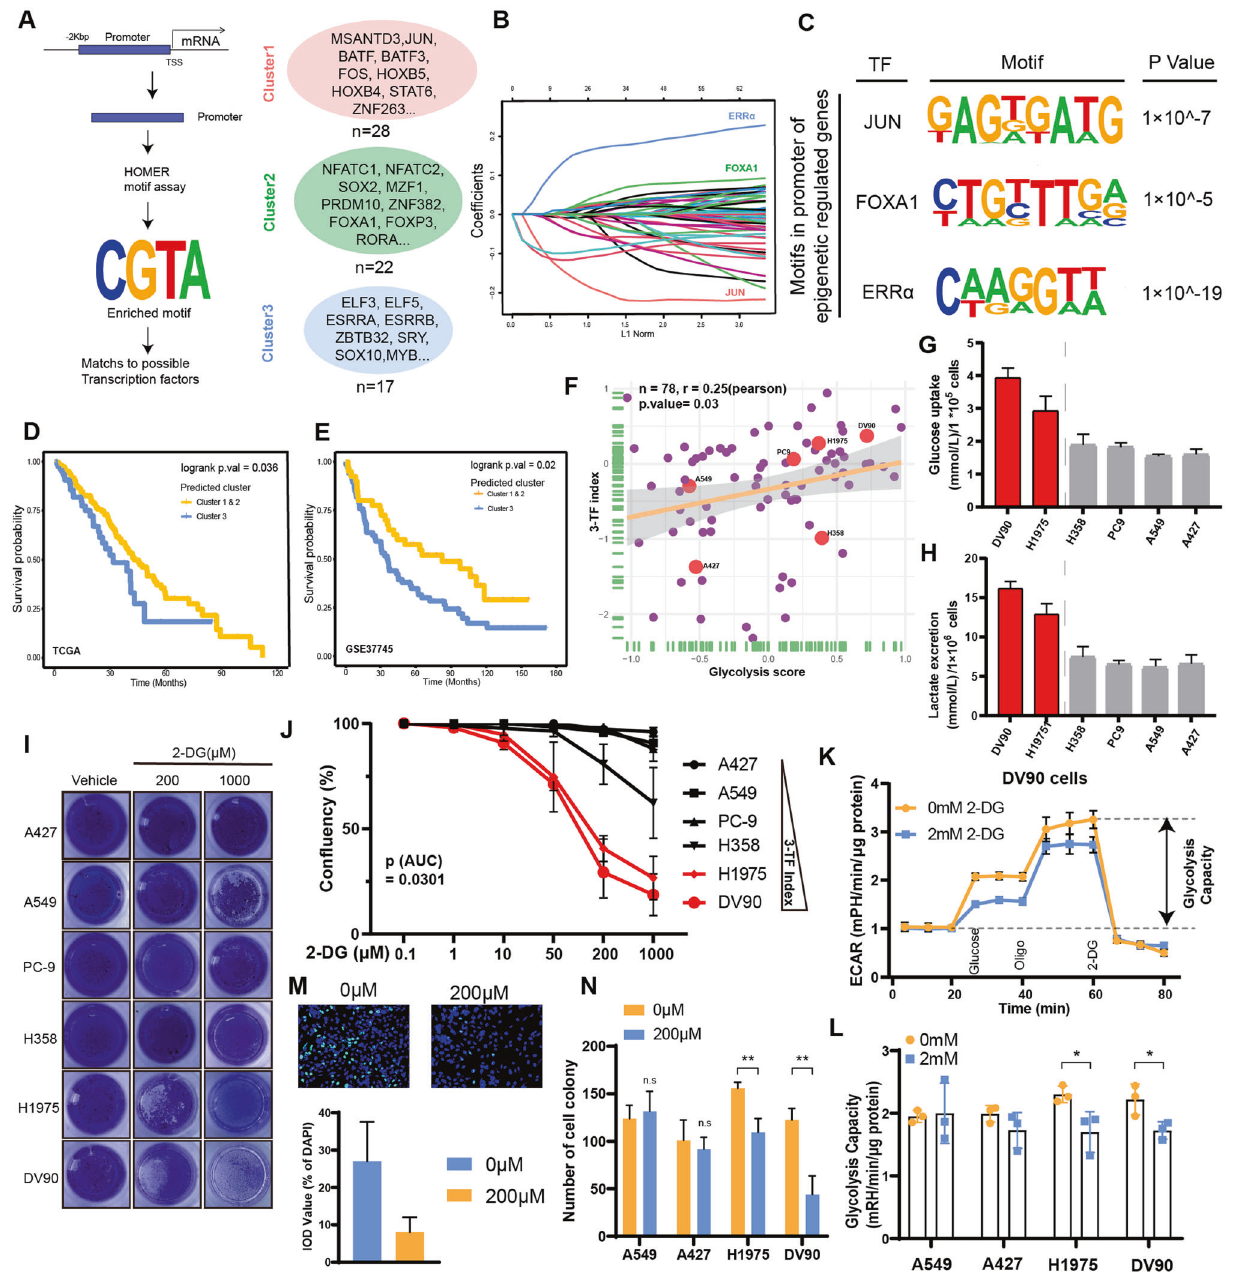
Fig. 3 Differential TF-SE interactions correspond with glycolysis reprogramming. A Schematic of the approach used to identify TFs with potential molecular function. B The LASSO coef fi cient pro fi les for the prediction of SHCs. C The motifs in the promoters of SE-regulated genes. D , E Kaplan – Meier survival curves for predicted clusters (according to the 3-TF index model) displaying overall survival in TCGA cohort and GSE37745. F Correlation plots showing the correlation between glycolysis score and 3-TF index value in 78 LUAD cell lines from the CCLE database. G , H There were tendencies of high glucose uptake and lactate excretion in cell lines with high 3-TF index than in cell lines with low 3-TF index. I , J Effect of 2-DG on the con fl uence of LUAD cell lines with high 3-TF index and low 3-TF index. Extracellular fl ux assays using Seahorse ( K , L ), EdU assay ( M ) and clone formation assay ( N ) showing that cell lines with high 3-TF index (DV90, H1975) have higher 2-DG sensitivity than cell lines with low 3-TF index (A549, A427). Asterisks indicate statistical signi fi cance; * P < 0.0.5; ** P < 0.01; *** P < non-cluster3-like cell lines. TFs may play a role of cofactor for SE (Fig. S3B). In addition, the malignant progression indicators, hijacking oncogenes ’ promoter and promote SE remodeling, including proliferation rate (Fig. S3C – E), invasion and migration which has been reported in previous studies [50]. Thus, we abilities (Fig. S3F), were found to be positively mediated by ERR α propose an axis in which the hetero-programming SE in cluster 3 in cluster3-like cell lines. While, the non-cluster3-like cell line did hijacks the oncogenes ’ promoters through the assistance of ERR α , not show above changes signi fi cantly. These fi ndings indicate that which ultimately promotes the aerobic glycolysis and malignant the aerobic glycolysis and malignant progression of the cluster 3 progression of the tumor. cell lines are mediated by ERR α , but had no signi fi cant effect on